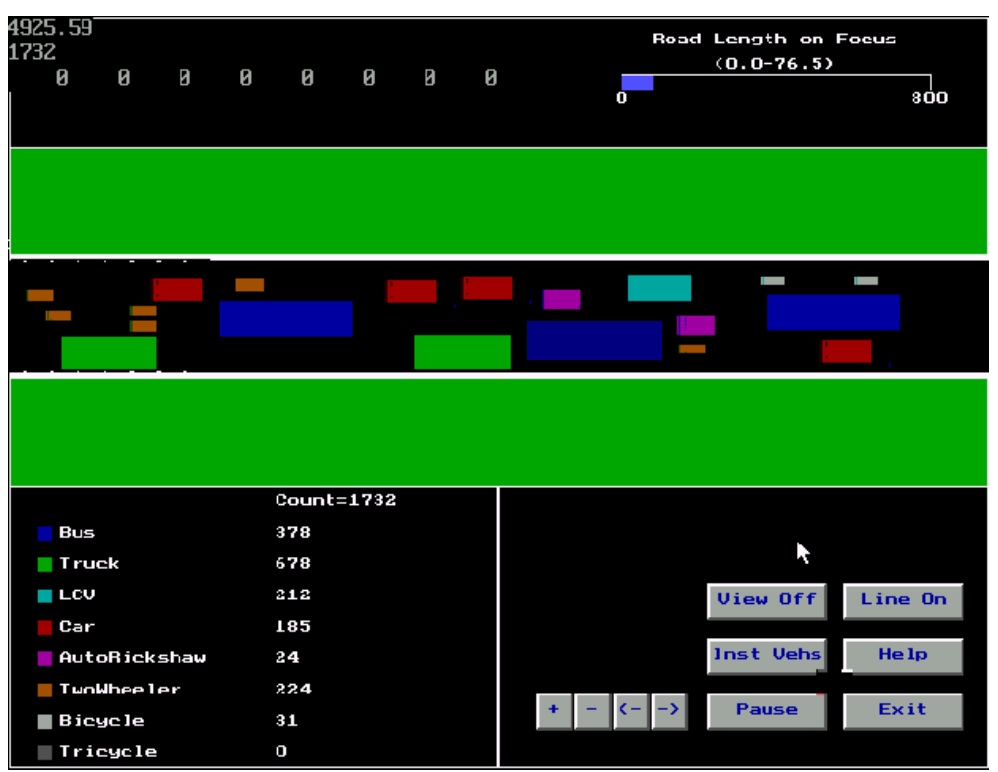
Figure 2. Snapshot of animation of simulated heterogeneous traffic